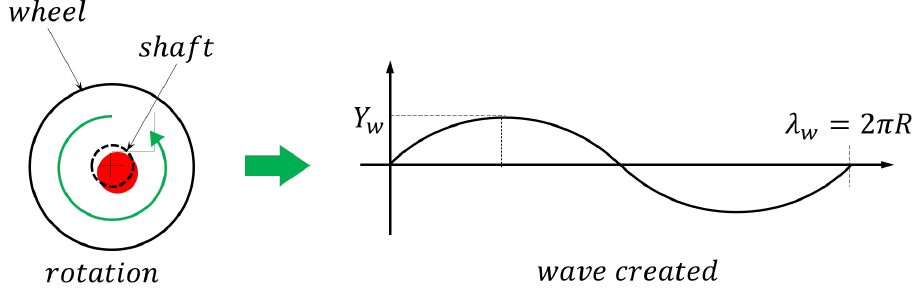
Figure 9. Periodic wheel noise